Question: Write a single sentence explaining what this figure depicts.
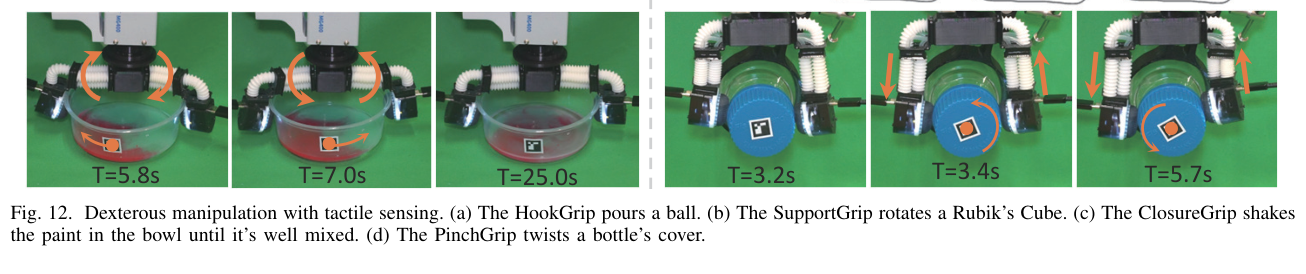
Answer: (a) captures the critical moment of stable gripping and the successful release of the ball. The cup’s angle and pouring trajectory are both tracked using an ArUco marker, confirming a precise pouring angle of 47.5◦. b) Rubik’s cube-rotating using SupportGrip. A Rubik’s cube (size 57 × 57 × 57 mm) was put beneath the palm of the gripper. Once the gripper achieved stable contact, the gripper began to rotate the cube’s bottom face, which was observed through tactile images. We conducted this rotating procedure twice. Fig.12 (b) illustrates key moments: the initial contact with the cube, the completion of the first rotation, and the completion of the second rotation. Notably, the contact areas on the sensor during the first rotation did not overlap with those during the second rotation, demonstrating the sensor’s sensitivity. An ArUco marker was utilized to track the rotation angle, which averaged 14.5◦per rotation. c) Dye-mixing using ClosureGrip. A bowl containing 10 ml of water i